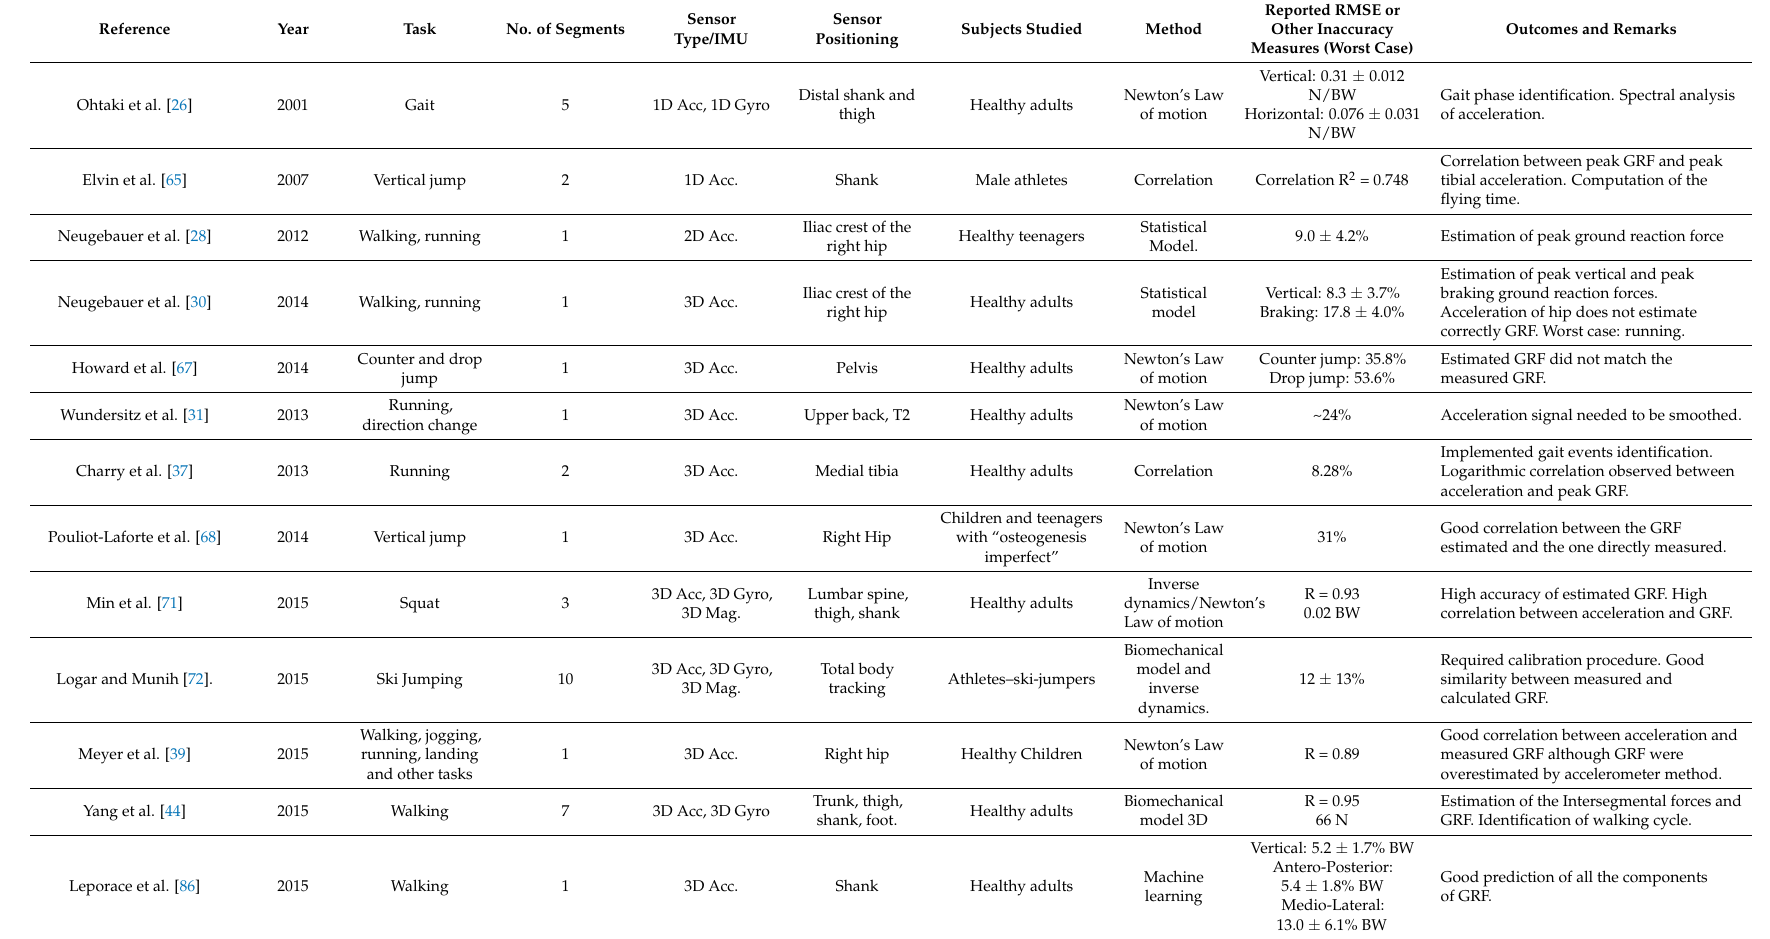
Table 1. List of the papers discussed.